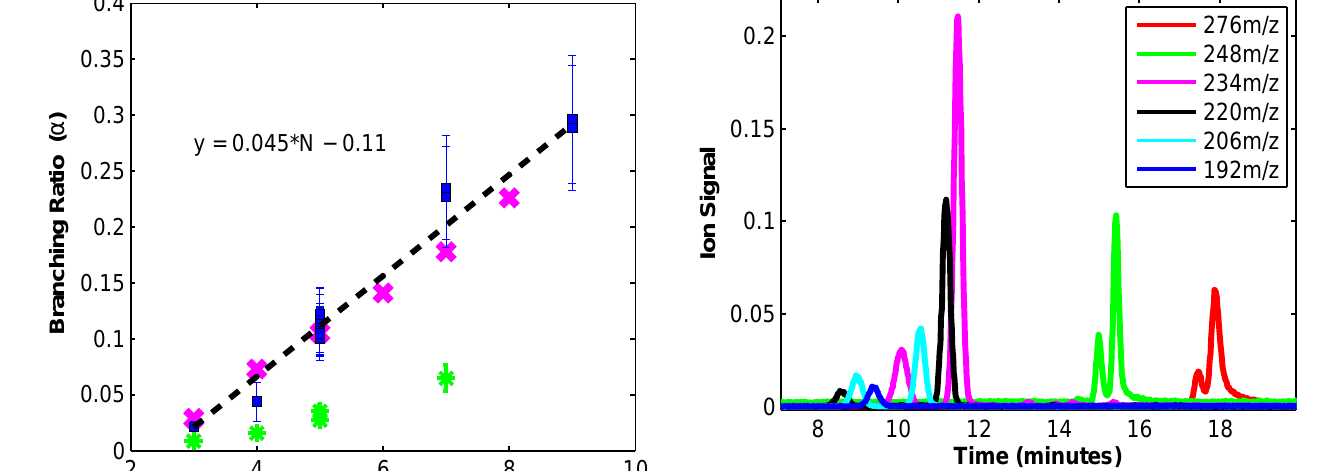
Figure 46. A chromatographic separation of hydroxy ni- Figure 6. A chromatographic separation of hydroxy nitrates trates formed from a set of alkenes in Experiment 19. 192 formed from a set of alkenes in Experiment 19. 192 m/z = ethene Figure 44. The isomer-averaged branching ratios, α , derived in m/z = ethene hydroxy nitrate, 206 m/z = propene hydroxy ni- Figure 4. The isomer-averaged branching ratios, α , derived in this hydroxy nitrate, 206 m/z = propene hydroxy nitrate; 220 this study (blue boxes, data from Table 44), compared to previ- trate; 220 m/z = methylpropene hydroxy nitrate; 234 m/z = 2- study (blue boxes, data from Table 4), compared to previously pub- ously published nitrate branching ratios (Arey et al., 2001 with pink methyl 2-butene hydroxy nitrate; 248 m/z = 1-hexene hydroxy m/z = methylpropene hydroxy nitrate; 234 m/z = 2-methyl lished nitrate branching ratios (Arey et al., 2001 with pink exes; exes; O’Brien et al., 1998 with green stars). Alkene nitrate yields nitrate; 276 m/z = 1-octene hydroxy nitrate. Isomer distributions 2-butene hydroxy nitrate; 248 m/z = 1-hexene hydroxy nitrate; from O’Brien et al., 1998 have been normalized by f a to account were determined based on integrating peak areas from chro- O’Brien et al., 1998 with green stars). Alkene nitrate yields from 276 m/z = 1-octene hydroxy nitrate. Isomer distributions were for H-abstraction channel in the same fashion as this study. The matograms. The later eluting peaks are prone to tailing and co- O’Brien et al. (1998) have been normalized by f a to account for error weighted fit derived from Fig. 44 is shown for hydroxy ni- determined based on integrating peak areas from chromatograms. elution. In such cases, Gaussian peaks shapes were used to decon- H-abstraction channel in the same fashion as this study. The er- trate branching ratios (black dotted line) from all measured alkenes volute co-eluting isomers and the trailing tail was assigned to the The later eluting peaks are prone to tailing and co-elution. In such yields a slope of 0 . 045 0 . 016 and intercept of 0 . 11 0 . 05 (er- ror weighted fit derived from Fig. 4 is shown for hydroxy ni- later eluting peak. cases, Gaussian peaks shapes were used to deconvolute co-eluting ± − ± rors are 2 σ ). This fit agrees well with the relationship derived by trate branching ratios (black dotted line) from all measured alkenes isomers and the trailing tail was assigned to the later eluting Arey et al., 2001, who calculated a slope of 0 . 0381 0 . 0016 and ± yields a slope of 0 . 045 ± 0 . 016 and intercept of − 0 . 11 ± 0 . 05 (er- an intercept of 0 . 073 0 . 009 for n-alkanes. − ± rors are 2 σ ). This fit agrees well with the relationship derived by Arey et al. (2001), who calculated a slope of 0 . 0381 ± 0 . 0016 and an intercept of − 0 . 073 ± 0 . 009 for n- alkanes.